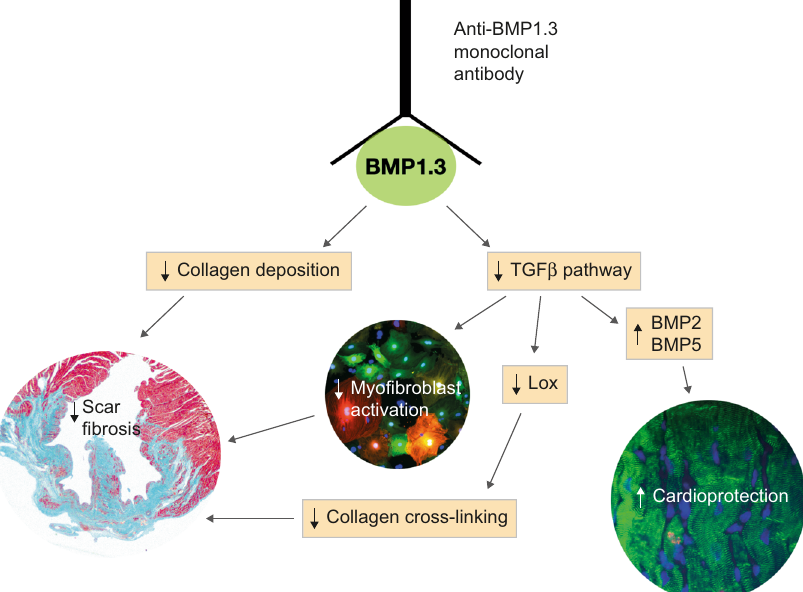
Fig. 5 Mechanism of action of anti-BMP1.3 antibody. The anti-BMP1.3 monoclonal antibody blocks the enzymatic activity of BMP1.3, exerting pleiotropic therapeutic effects after MI. On the one hand, BMP1.3 inhibition reduces collagen maturation. On the other hand, it results in TGF β pathway inhibition, which in turns reduces myo fi broblast activation, Lox expression and collagen cross-linking and increases the expression of cardioprotective